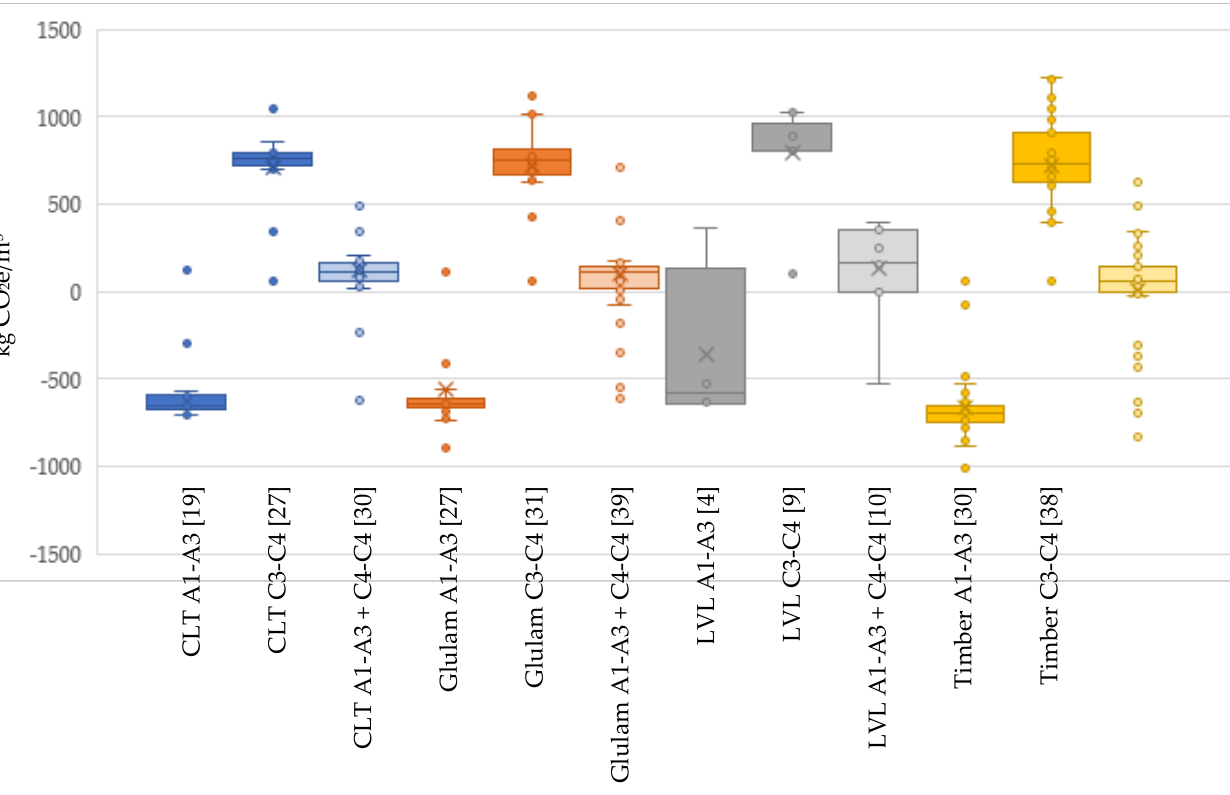
Figure 6. Reported GWP from production (A1–A3), EoL (C3–C4), and total (A1–A3 + C3–C4) from the sample of 81 structural wood product EPDs in accordance with EN 15804. Numbers in brackets indicate the number of data points, i.e., relevant product scenarios